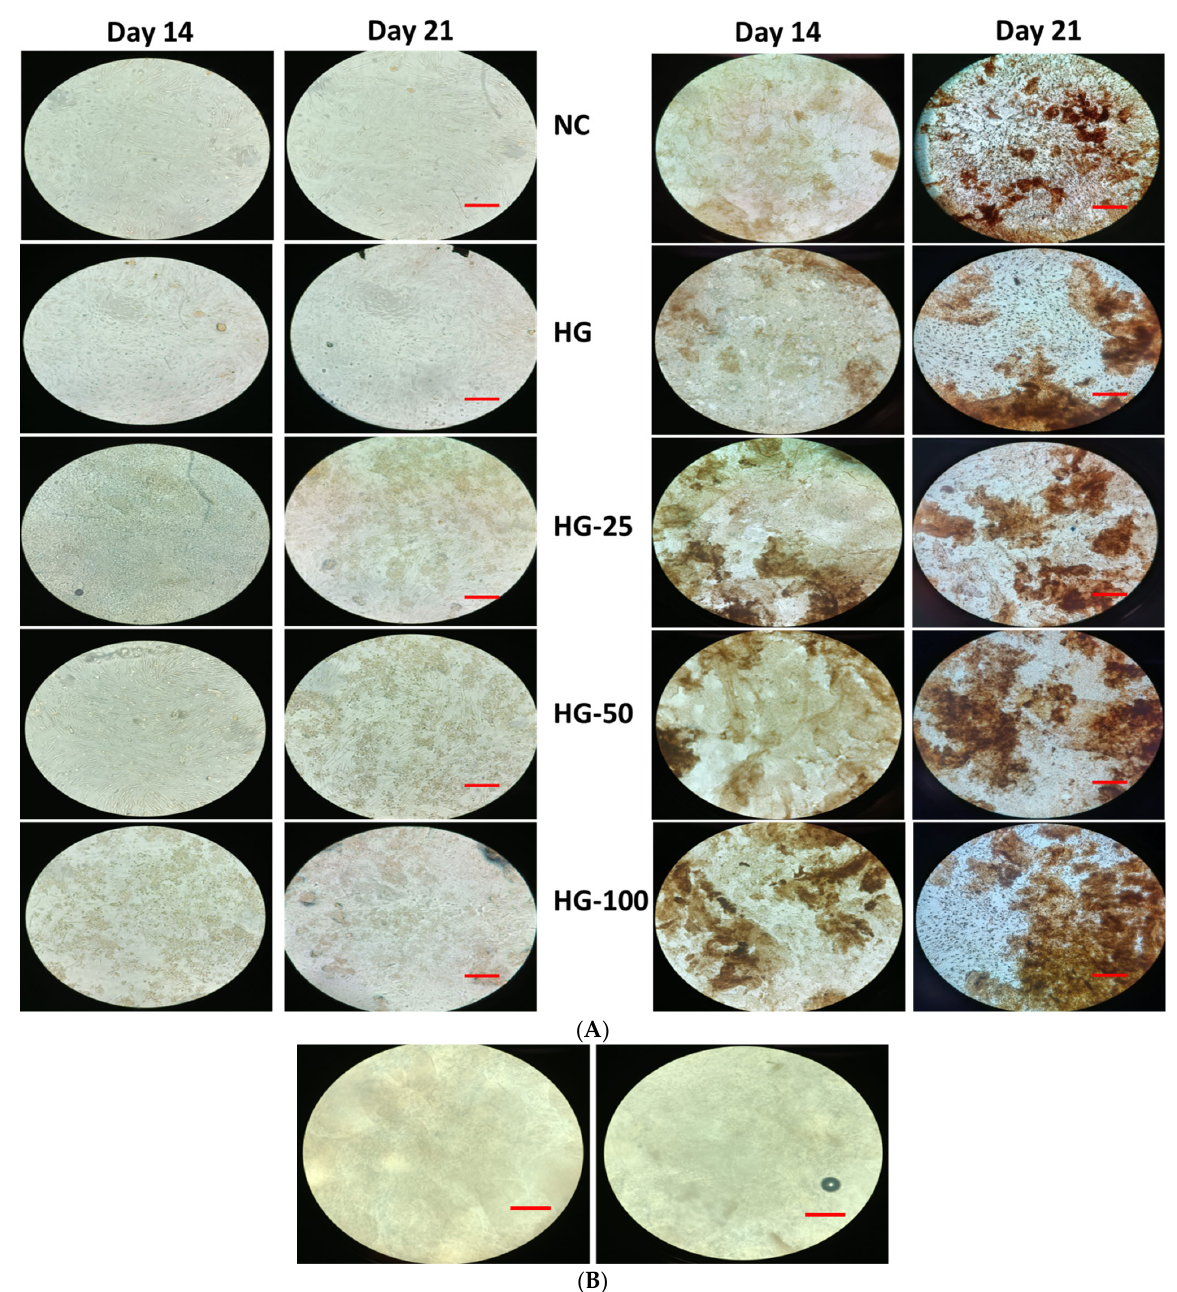
Figure 6. Von Kossa staining of osteogenic cells differentiated from MSC cultured on hydrogels for 14 and 21 days. Cells without osteogenic supplement ( Left ) and cells with osteogenic supplement ( Right ). ( A ) Cells cultured on hydrogels and stained, ( B ) only hydrogels with von Kossa stain without cells and supplement. NC—cells without hydrogels, HG—hydrogels without VEGF, HG-25, -50, and -100—hydrogels with 25 ng/mL, 50 ng/mL, and 100 ng/mL of VEGF, respectively. Scale bar 10×—100 µm.